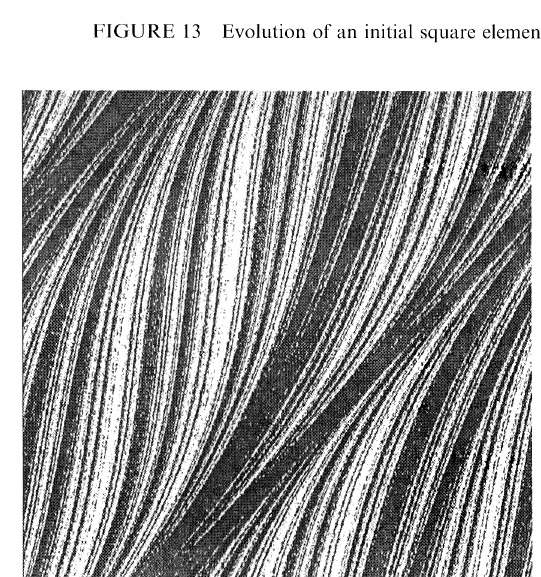
FIGURE 14 Phase diagram of the chaotic nonstrange attractor in the Arnold map (8) for h-0.15. information